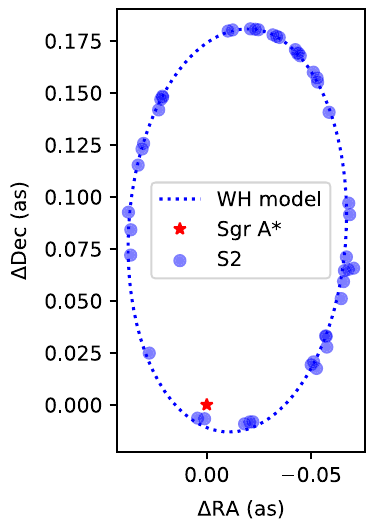
Fig. 2 OrbitofS2aroundthegalacticcenter(SgrA (cid:2) )asamodelfitting using the WH model I. We used the observational data from [36]. In the particular case we used the best fit r 0 = 1 . 03 M and γ = − 0 . 24. We work in mass units 4 . 07 × 10 6 M (cid:9) =